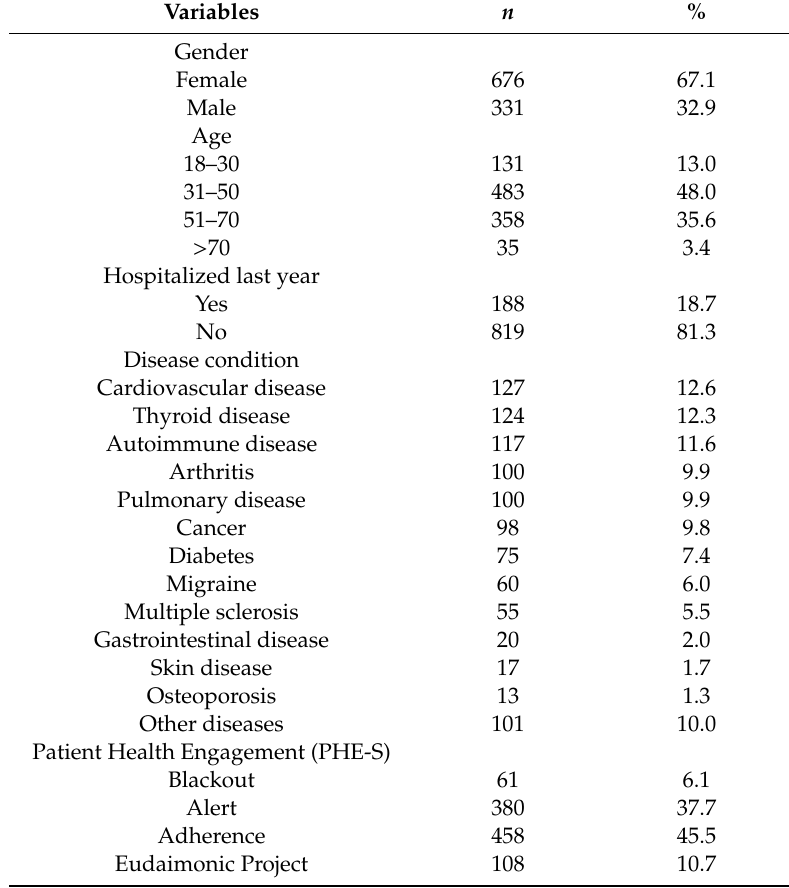
Table 1. Sample characteristics.